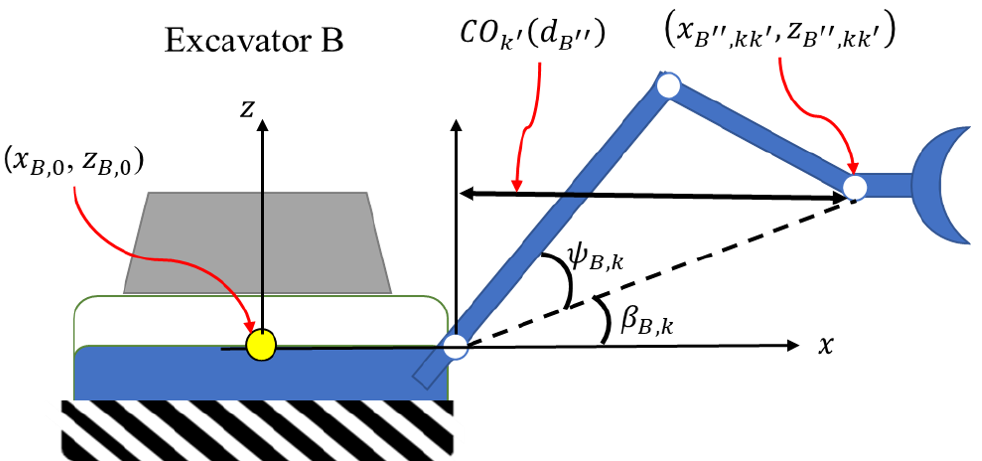
) , and CO j ( d (cid:48)(cid:48) ) are marked. k and k (cid:48) were chosen as , z B B (cid:48)(cid:48) , ij B (cid:48)(cid:48) , ij